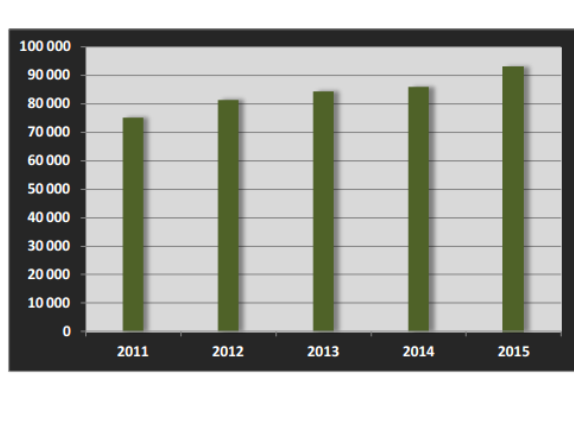
Figure 1. Total number of recorded accidents in the Czech Republic from